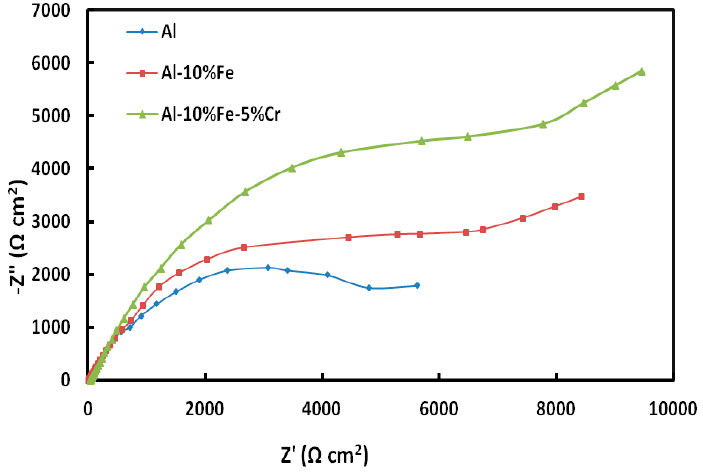
R ct corresponds to a lower j corr .